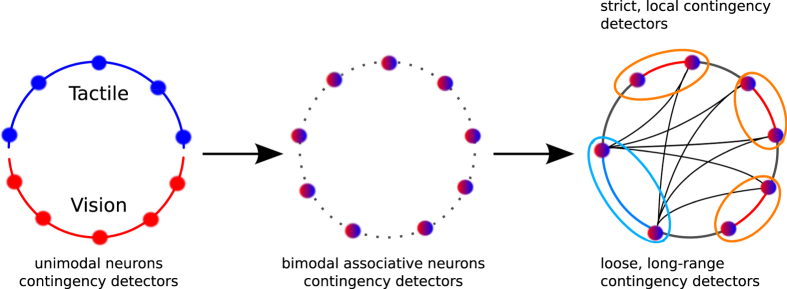
The integration of visual and tactile signals in the associative map and then in the recurrent map permits to be robust to spatio-temporal disturbances of distal multimodal events.The organization of the recurrent map into a small-world network can explain the synaptic multisensory integration for loose contingency detection; graphics inspired by2838.